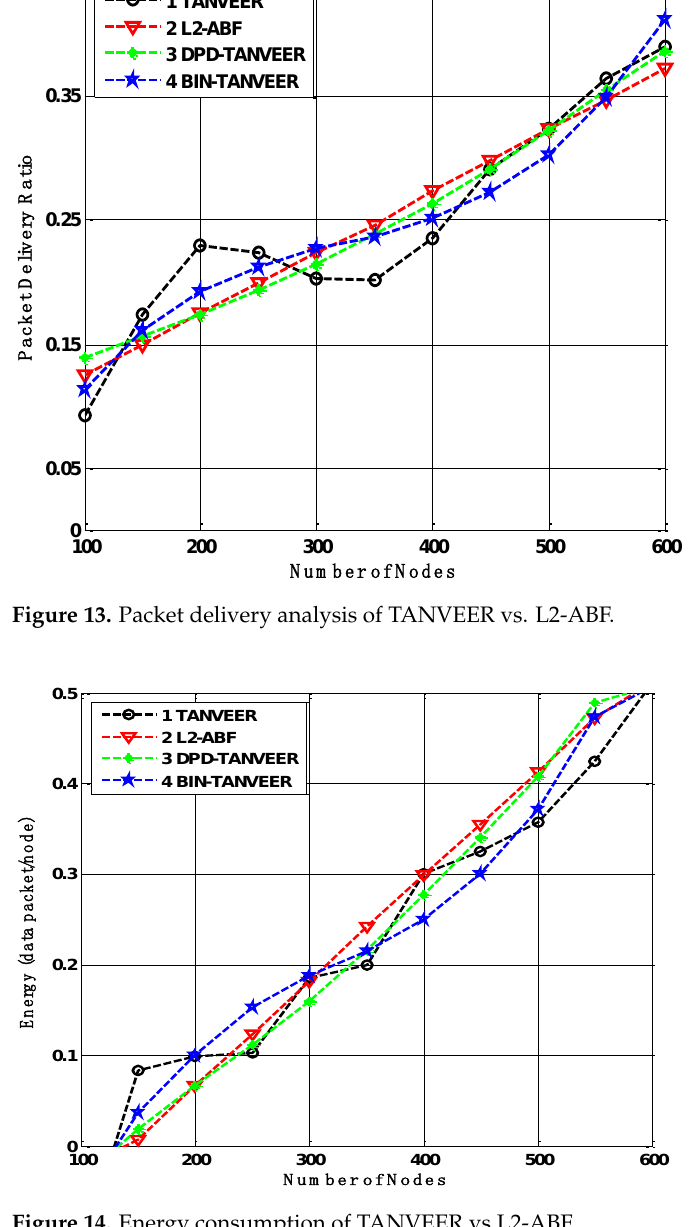
Figure 14. Energy consumption of TANVEER vs L2-ABF.